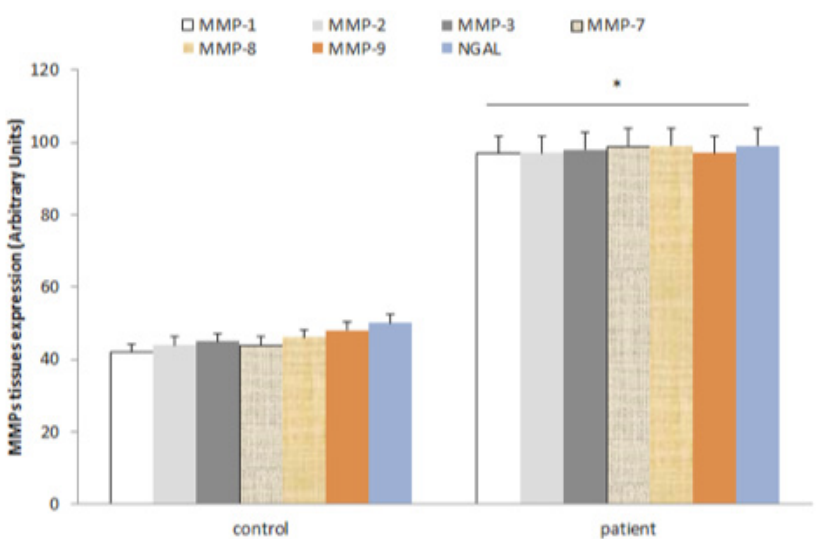
Figure 6: MMP-s and NGAL tissue expression in healthy and in aneurysmatic segments of the patient, measured through western blot analysis on the tissues taken from axillary artery aneurysm at the time of the surgery.